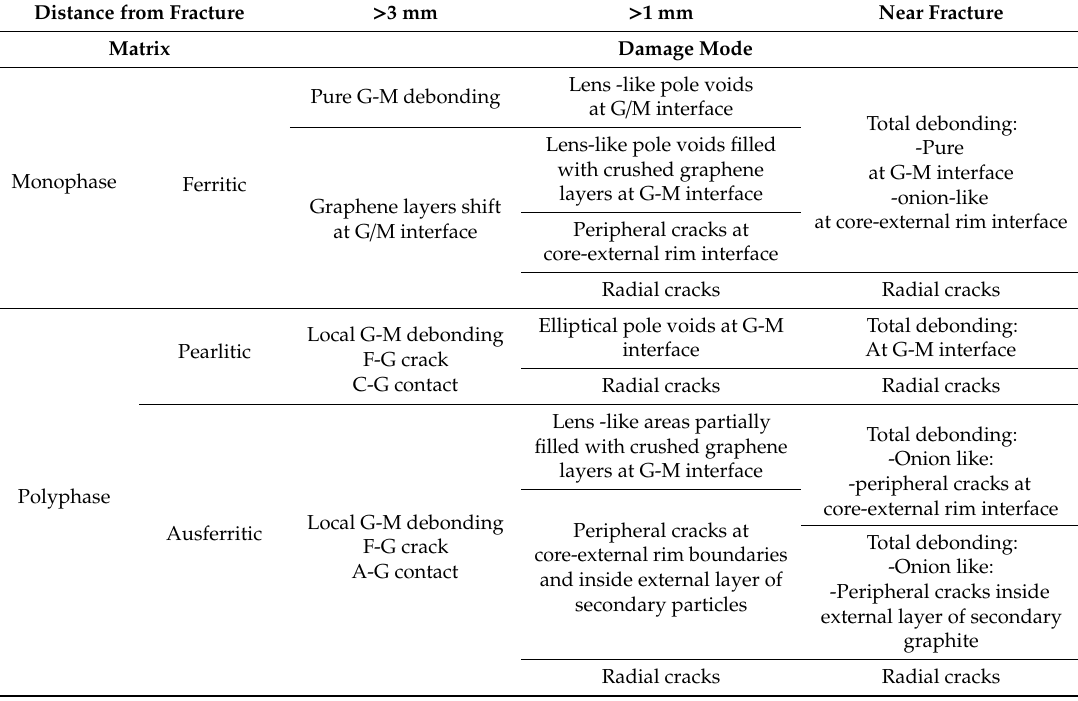
Table 3. G-M debonding mode and internal cracks path observed in the examined cast iron types. Distance from